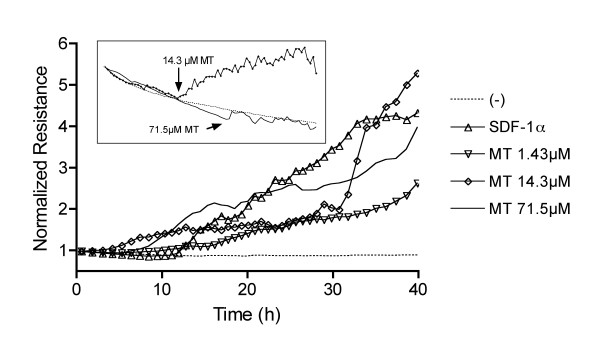
Dose response of Jurkat T cells to metallothionein measured by ECIS/taxis. Jurkat T cells were added to the cell wells and the indicated chemoattractant was loaded into the opposing well. SDF-1α is used as a positive control. The resistance measured at the electrode between the two wells is shown. Inset: A 3 hour window of data on an expanded scale is shown to highlight the arrival of cells on the electrode. Arrows indicated the time of arrival of the first cells leading to the appearance of small fluctuations in resistance.